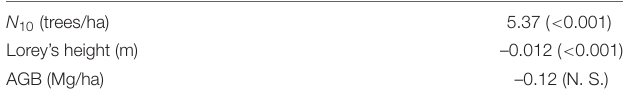
TABLE 2 | Slope estimates of linear models of each quadrat-level forest structure metrics to the wind speed correction factor, with p -Values in parentheses. N 10 (trees/ha) 5.37 ( < 0.001) Lorey’s height (m) –0.012 ( < 0.001) AGB (Mg/ha) –0.12 (N.